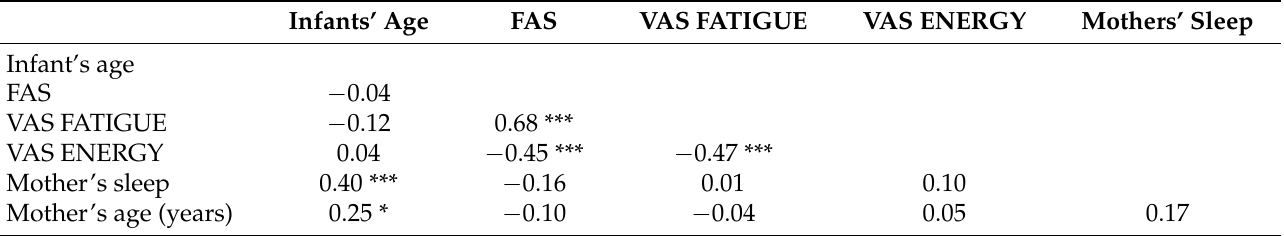
Table 2. Correlations between the three fatigue scales (FAS, VAS FATIGUE and VAS ENERGY), sleep (hours per night) and the age of their infants, for the